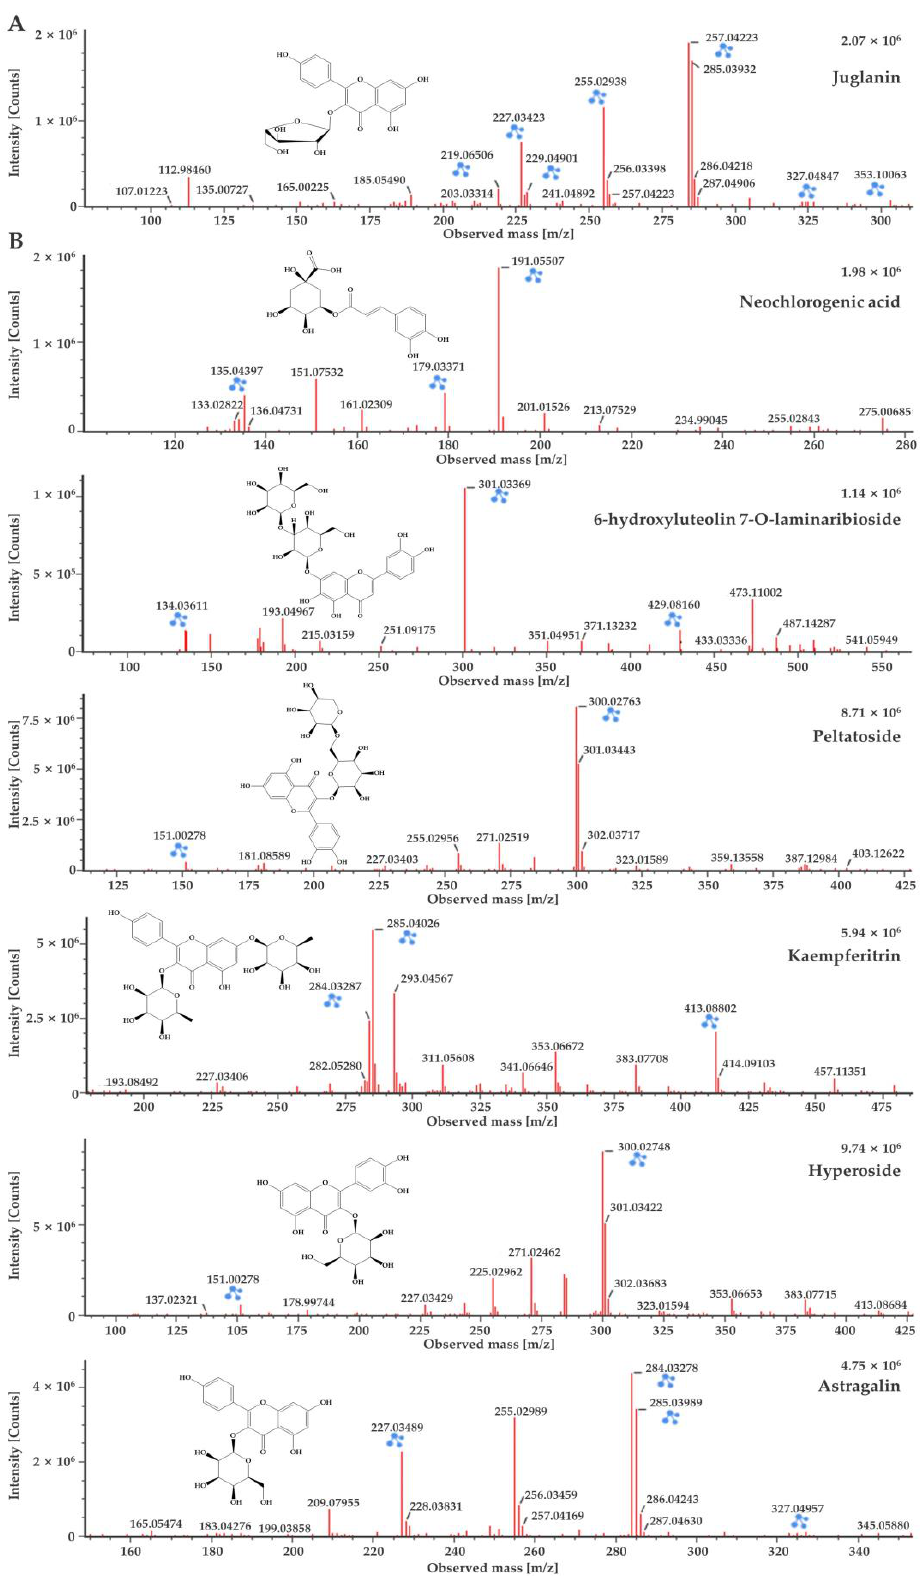
Figure 3. UPLC-QTOF-MS analysis of the major components in terms of matching scores of D. lacera ( A ), and D. bissetiana ( B ) extracts.